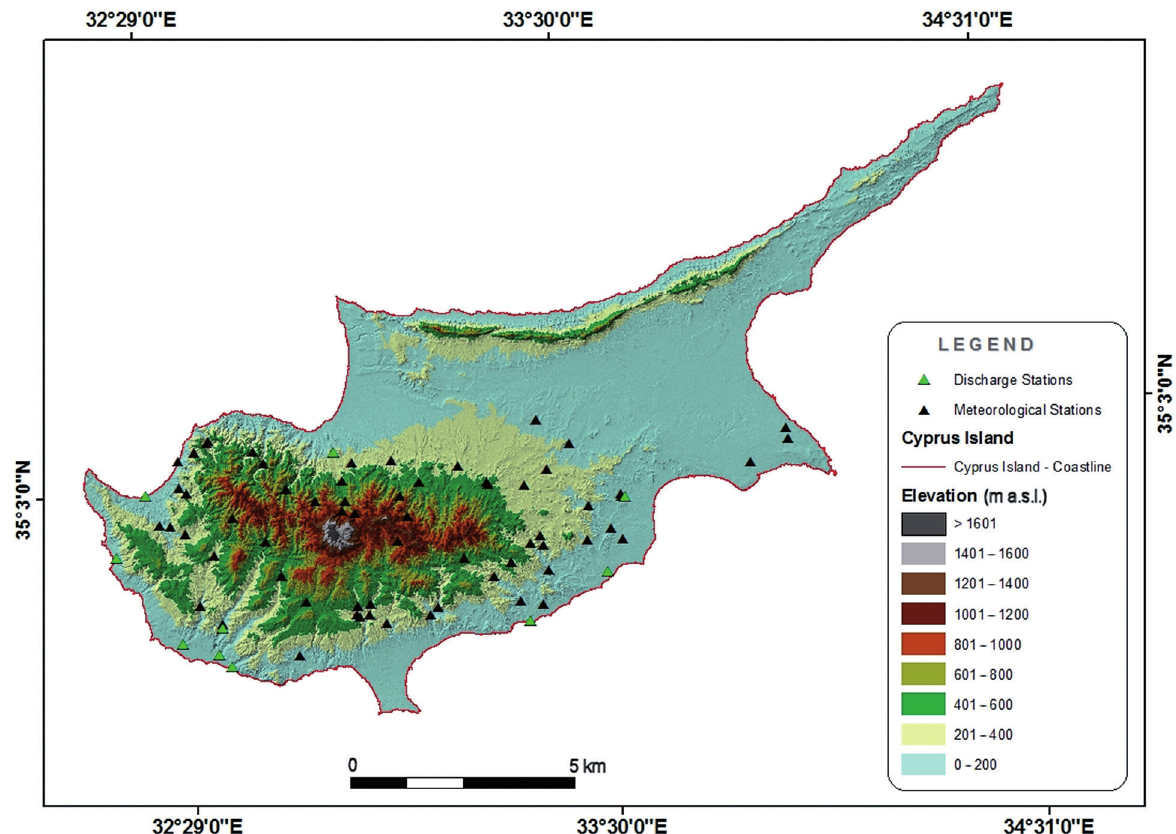
Fig. 1. Cyprus Island map displaying stations